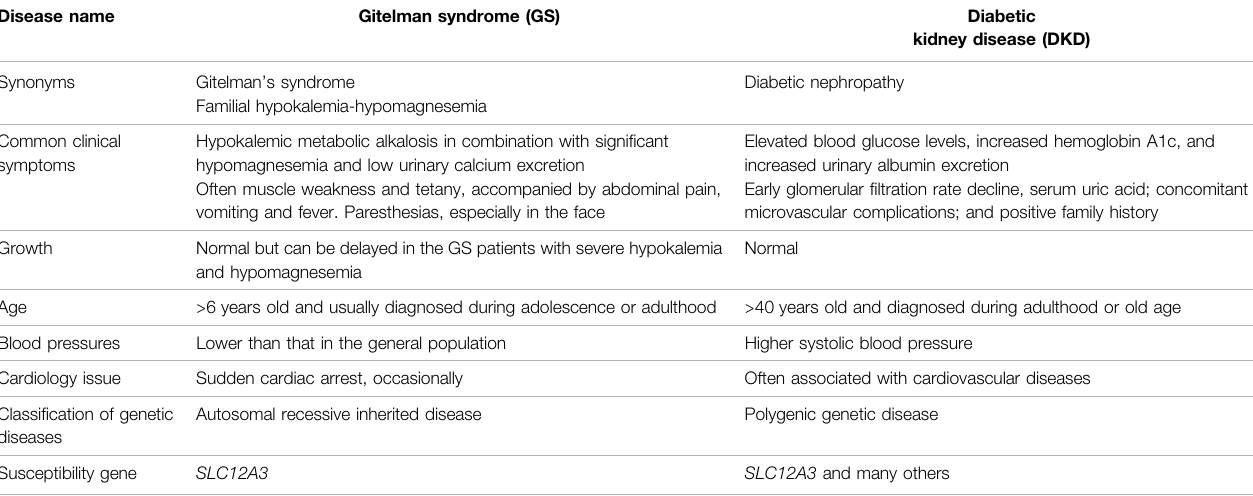
TABLE 2 | Clinical characteristics and genetic disease classi fi cation of Gitelman syndrome and diabetic kidney